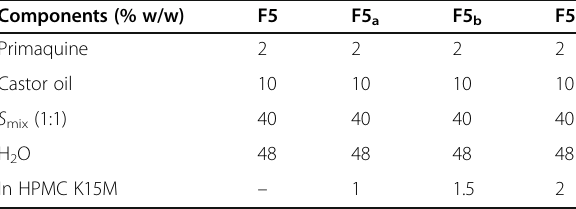
Table 3 Composition of nanoemulgel formulations (% w/w) Components (% w/w)